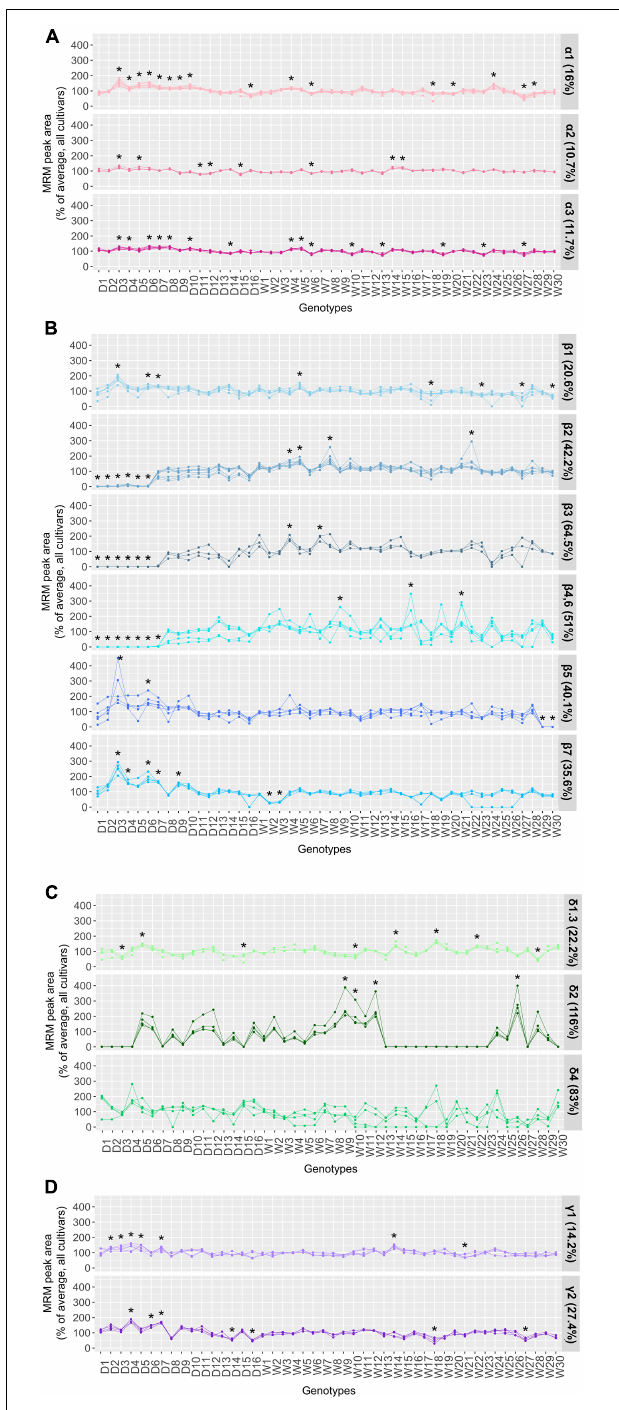
FIGURE 3 | Relative quantitation of the marker peptides monitored for (A) α -, (B) β -, (C) δ -, and (D) γ -conglutin families. The line graphs in each panel compare the relative abundance of the peptides measured for each conglutin subfamily. For ease of comparison the MRM peak area of each peptide was converted to percentage relative to the average peak area for all accessions. One-way ANOVA with Dunnett test was conducted for the multiple comparisons of the experimental groups and determining the significant differences (* p <